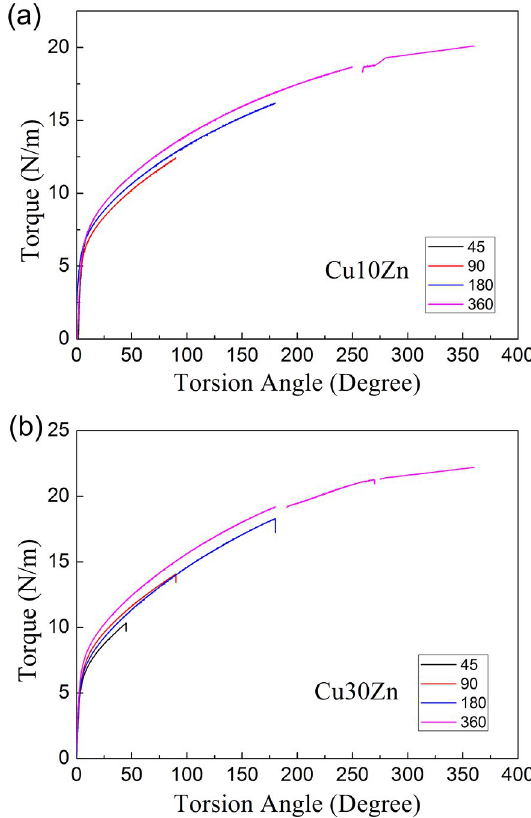
Figure 1. The torque versus torsion angle curves of the Cu10Zn and Cu30Zn